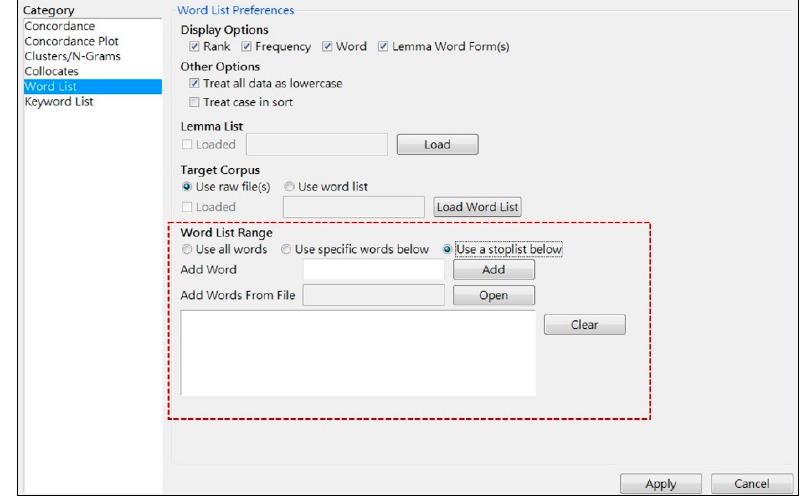
Figure 4. Limiting the word list range on AntConc 3.5.8.